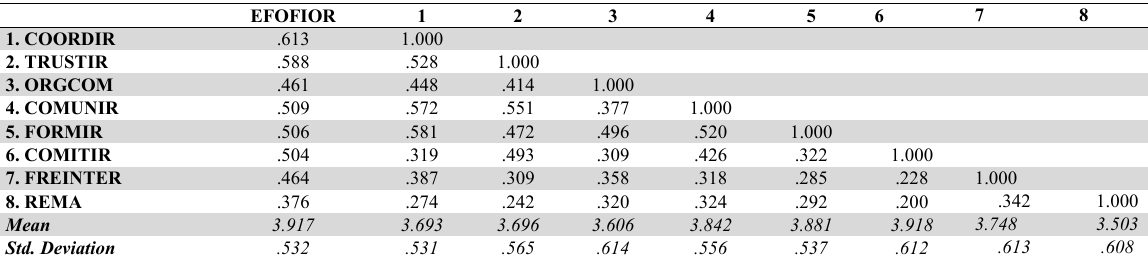
Correlation Matrix between Variables